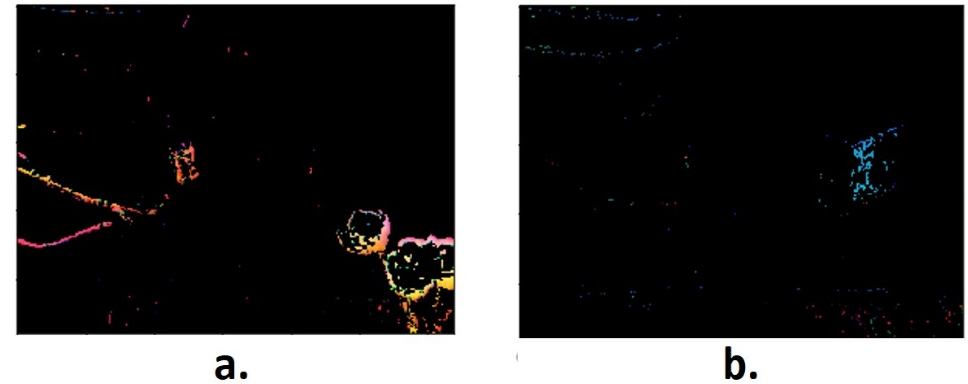
Figure 5. Mask of the interest Regions: ( a ) Target; ( b ) Probe end. The barycenter of the objects is employed as central points for sampling the regions of interest, with a later transformation to gray-scale and the Laplacian operator for the extraction around the edges [13–15]. The matrixes resulting from the convolution process are vectored, stored, and used to calculate the variances, probability distributions, and entropies. Autofocus operator developed used as the first operation to extraction the Laplacian from the matrix or the image for the vectors x e y is characterized by: